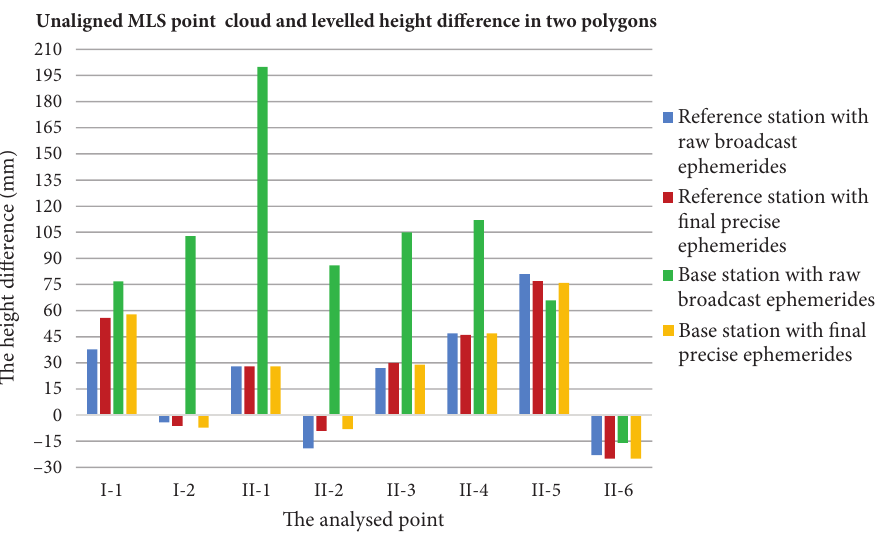
Figure 6. Unaligned MLS point cloud and levelled height difference in two polygons when four different computation schemes were used (Annok,